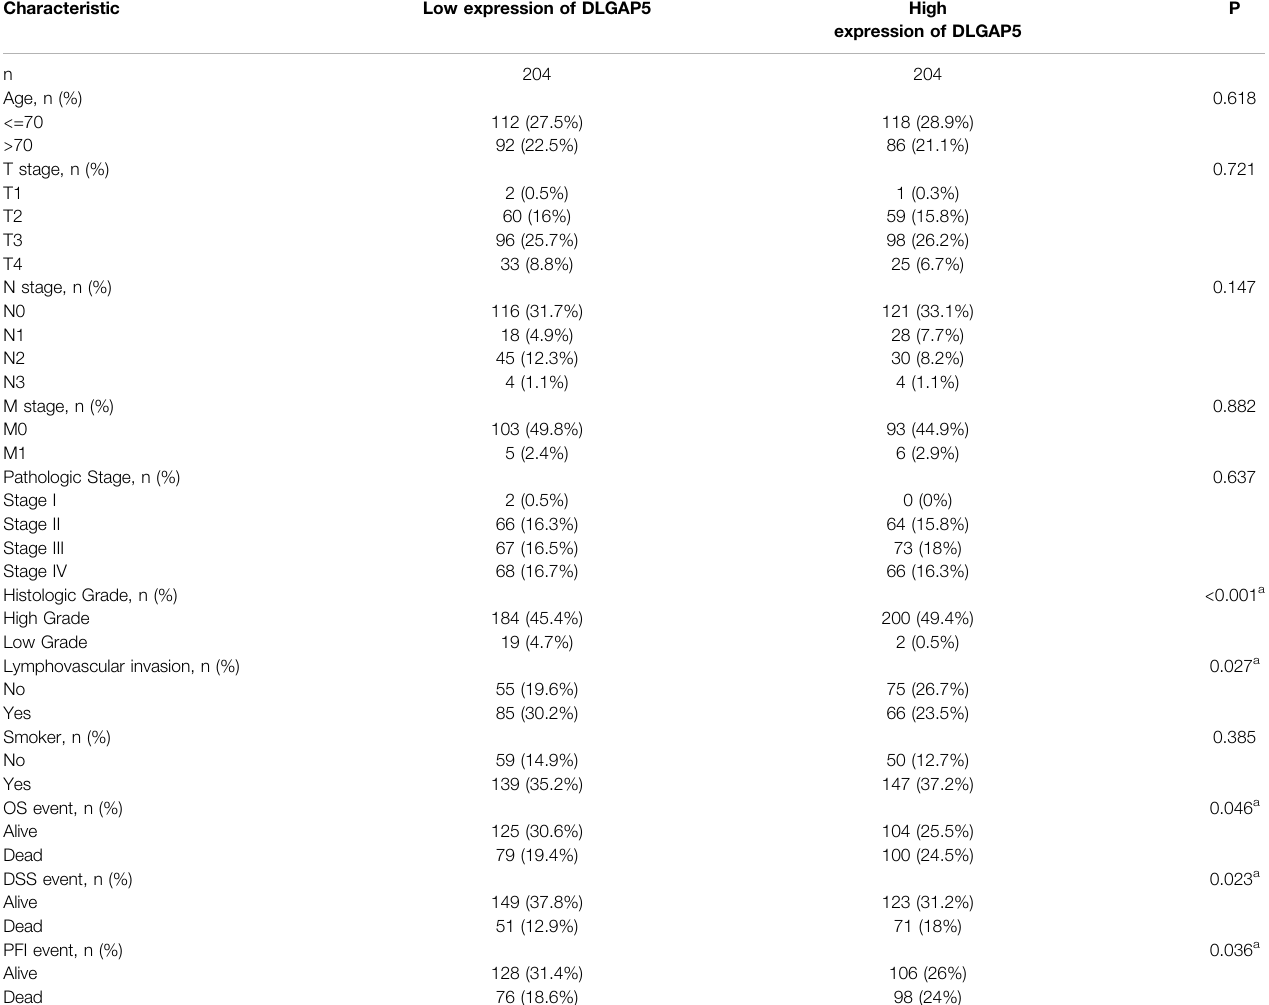
TABLE 1 | The clinical characteristics in BC with low and high expression of DLGAP5